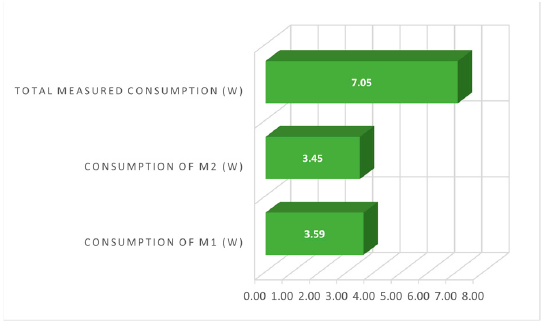
Figure 44. Power consumption—simulated in the case of the two-wheeled robot.